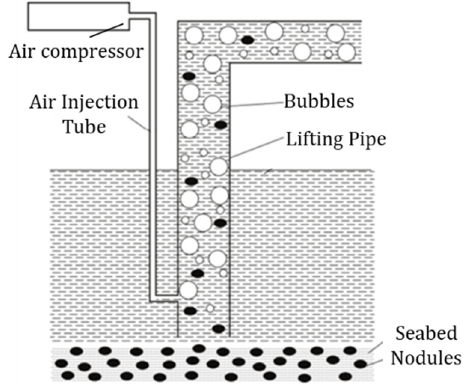
Figure 2. Schematic diagram of air lifting system.